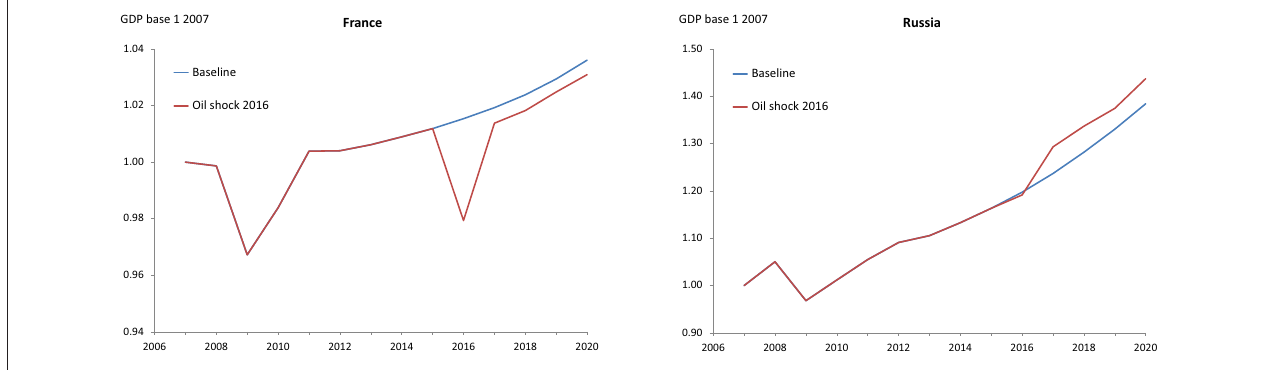
FIGURE 6 | GDP trajectories of France and Russia under baseline and oil shock scenario, IMACLIM-S and POLES coupled modeling.